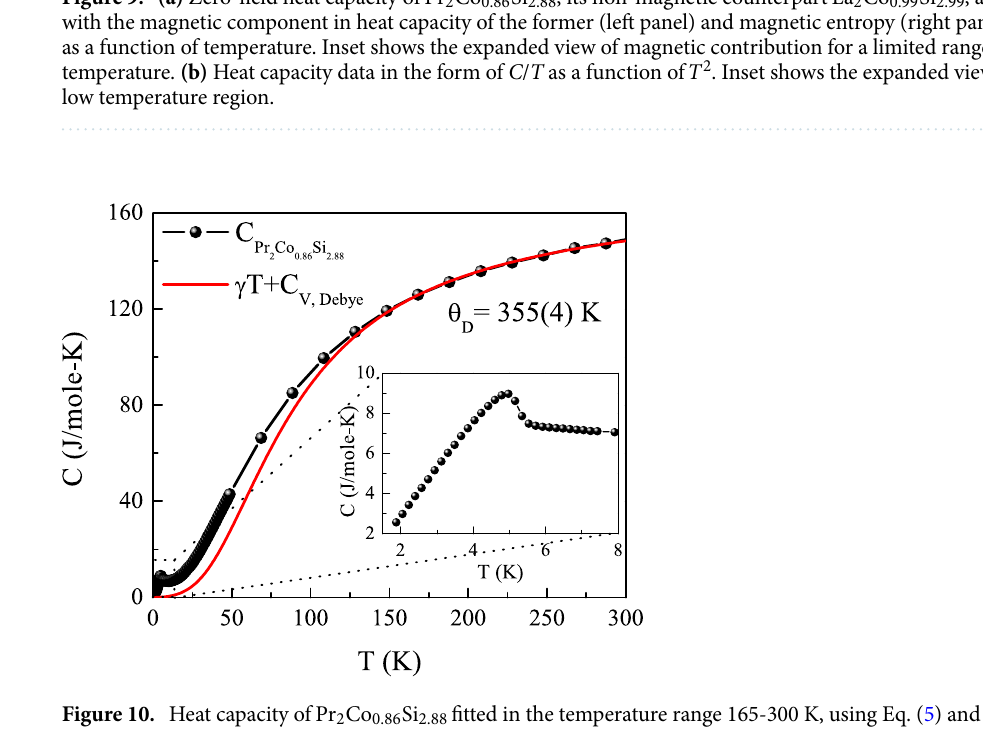
Figure 10. Heat capacity of Pr 2 Co 0.86 Si 2.88 fitted in the temperature range 165-300 K, using Eq. (5) and extrapolated down to 0 K. Inset presents the experimental C ( T ) data in the region of magnetic